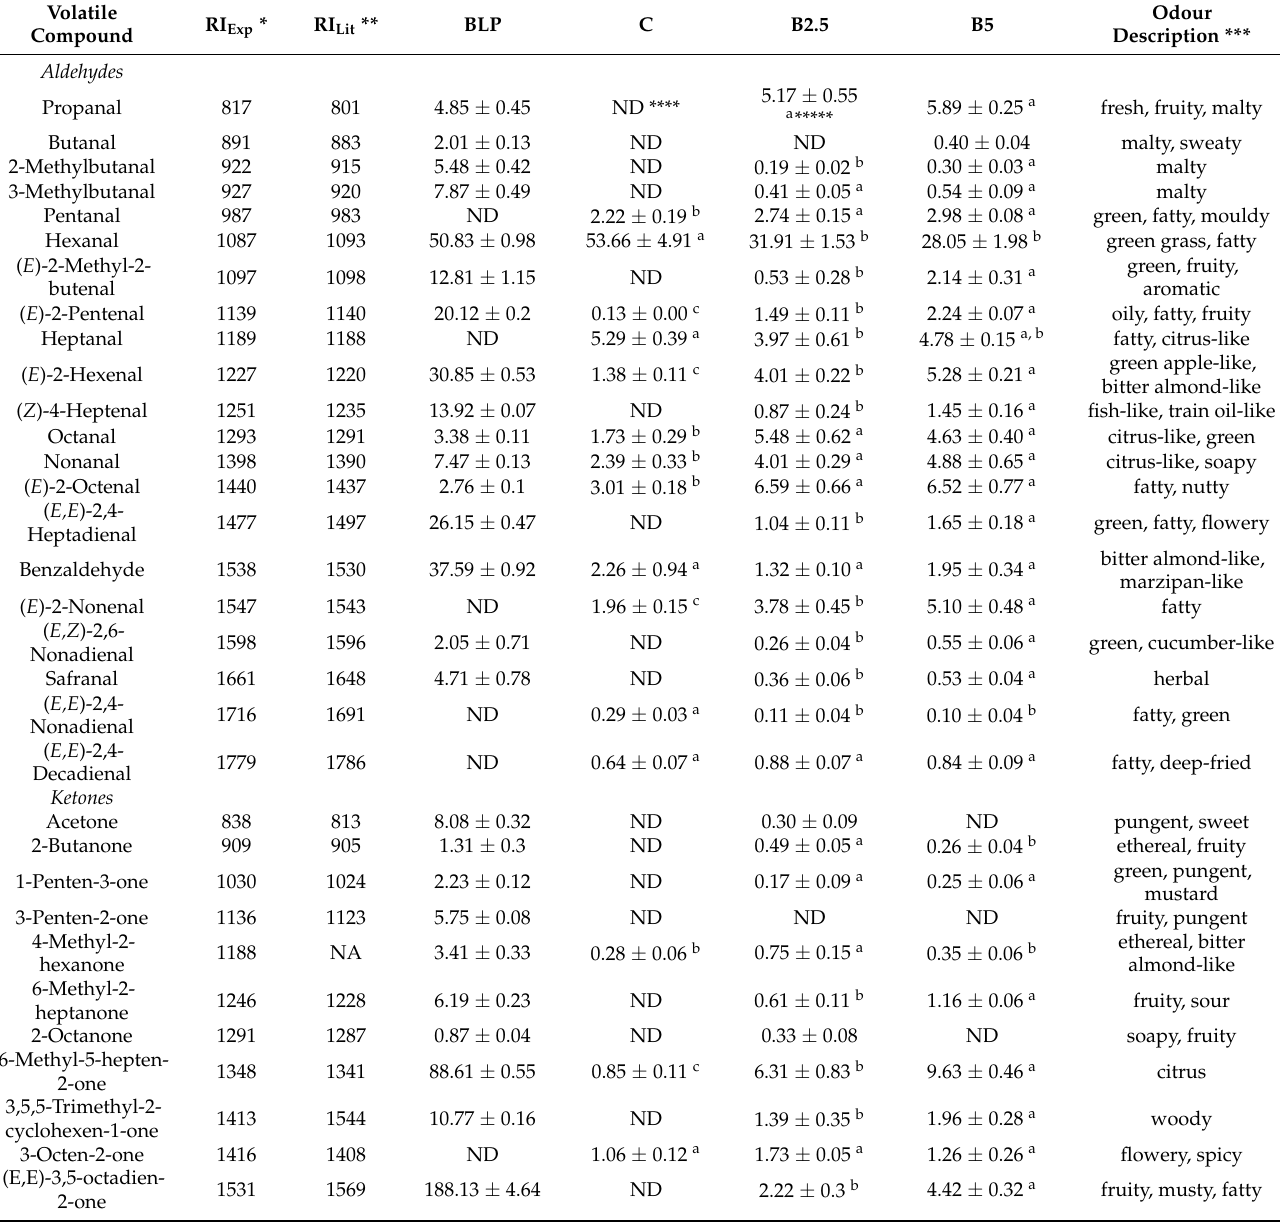
Table 3. VOCs of previously reported aroma activity identified in broccoli leaf powder (BLP), control (C) and experimental pasta (B2.5; B5). Data are expressed as the peak area [ × 10 6 ]. Statistical analysis was performed to compare pasta samples (C, B2.5 and B5); different letters in a row indicate statistically significant ( p -value < 0.05) differences between the